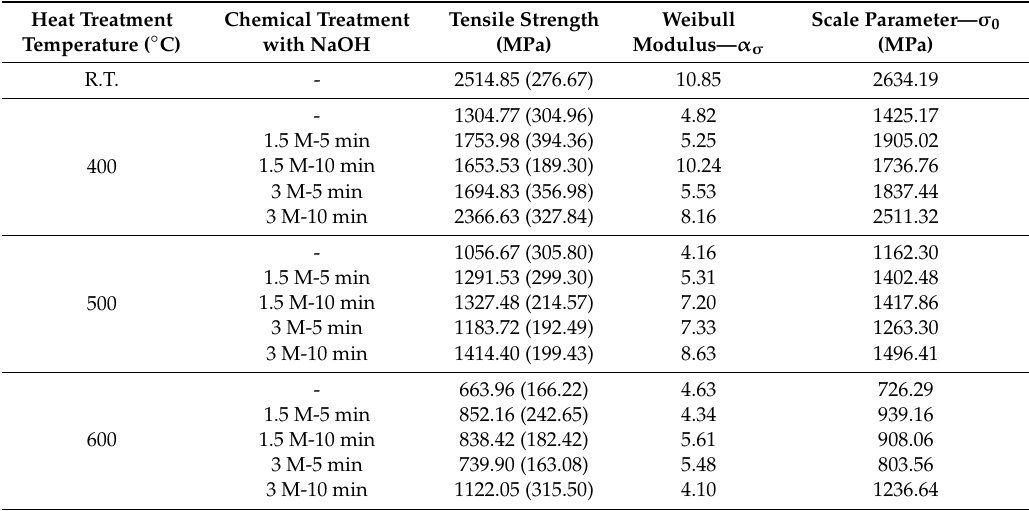
Table 1. Average tensile strength for regenerated basalt fibres after NaOH treatment and Weibull parameters of the strength distribution (standard deviation in parentheses).